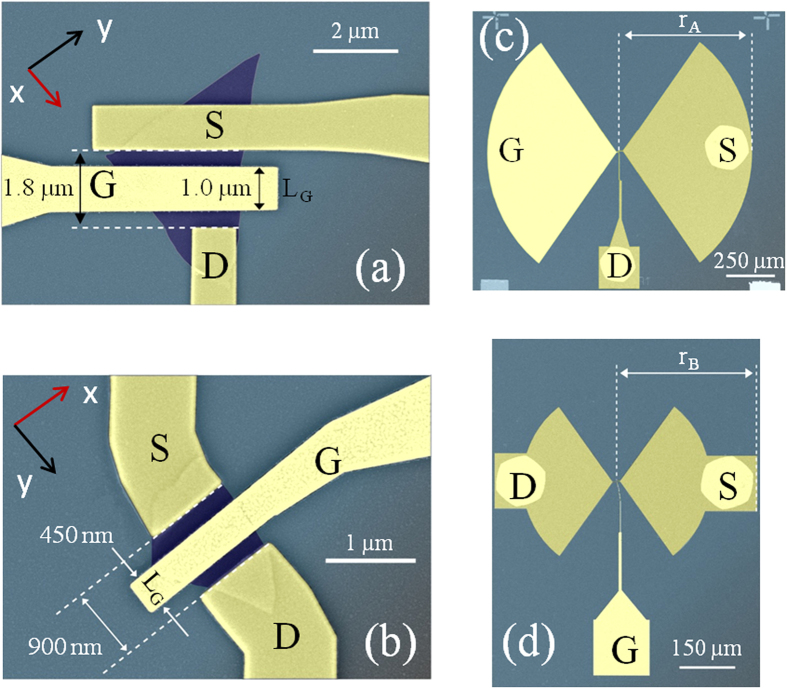
Device Fabrication.(a,b) False colors scanning electron microscope (SEM) images of the top-gated FETs in sample A (a) and sample B (b), respectively. (c,d) False colors SEM images of the patterned bow-tie antennas in sample A (rA = 0.5 mm) and sample B (rB = 0.25 mm), respectively.